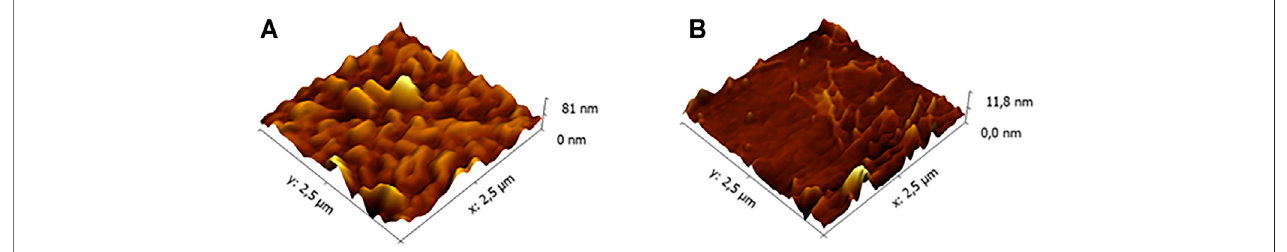
FIGURE 3 | Atomic force microscopy (AFM) morphologies of (A) a commercial and (B) low-roughness